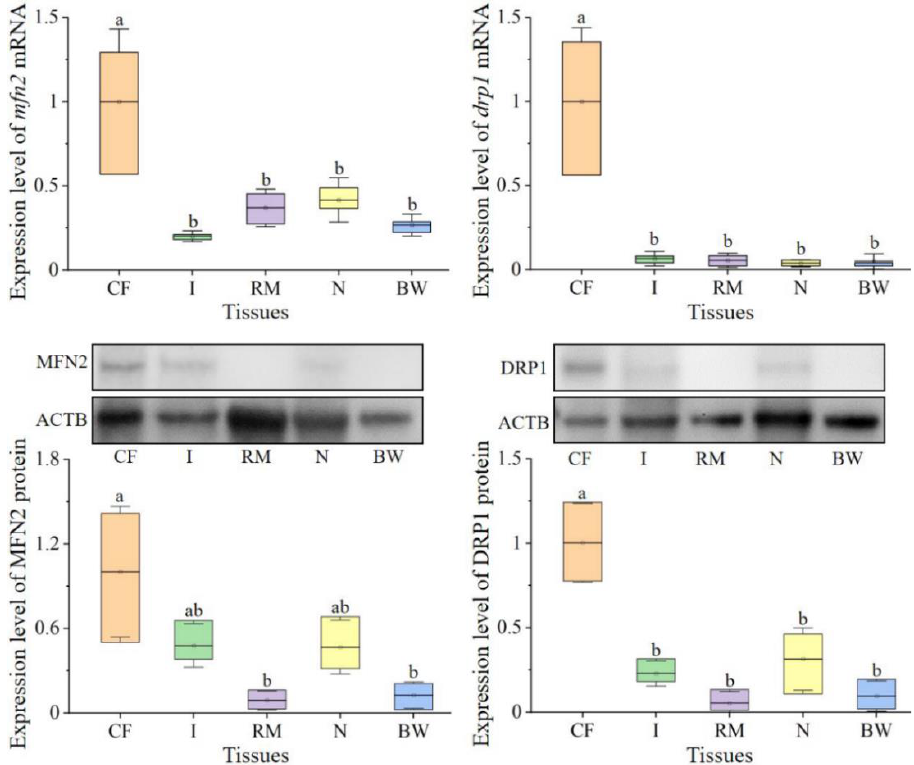
Figure 3. Expression of mfn2 and drp1 mRNA and proteins in tissues. The different letters above columns indicate significant differences ( p < 0.05). BW: body wall, CF: coelomic fluid, I: intestine, N: nephridium, RM: retractor muscle.